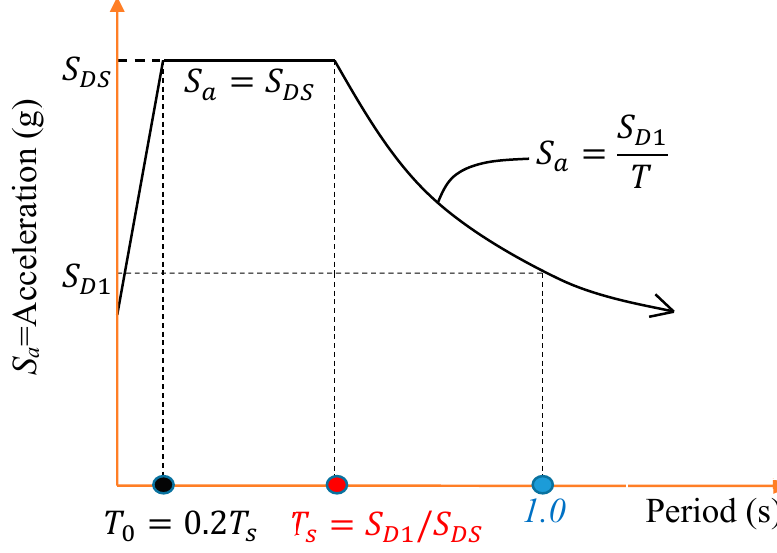
Figure 5. Seismic response spectrum according to IBC 2006 [25].